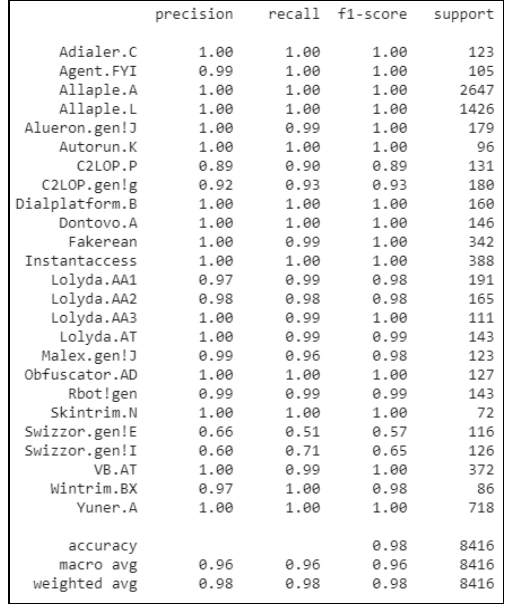
Figure 13. Performance metrics for CNN model for malware classification using transfer learning.